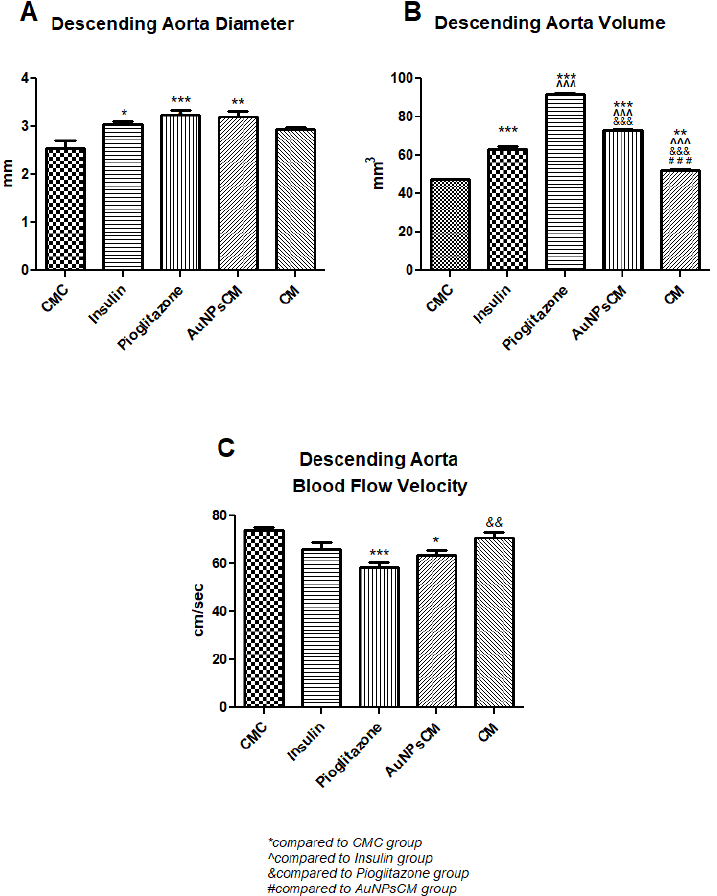
Figure 7. Descending aorta variations of diameter ( A ), volume ( B ) and blood flow velocity ( C ) in rats with 9 months of HFD and the last month with experimental-induced diabetes mellitus and treatment: CMC (carboxymethylcellulose), insulin, pioglitazone, AuNPsCM (gold nanoparticles functionalized with Cornus mas L. extract) or CM ( Cornus mas ). The parameters were expressed as means ± SD (* p < 0.05, ** p < 0.01, *** p < 0.001 compared to CMC group; ˆˆˆ p < 0.001 compared to Insulin group; && p < 0.01, &&& p < 0.001 compared to Pioglitazone group; ### p < 0.001 compared to AuNPsCM group).